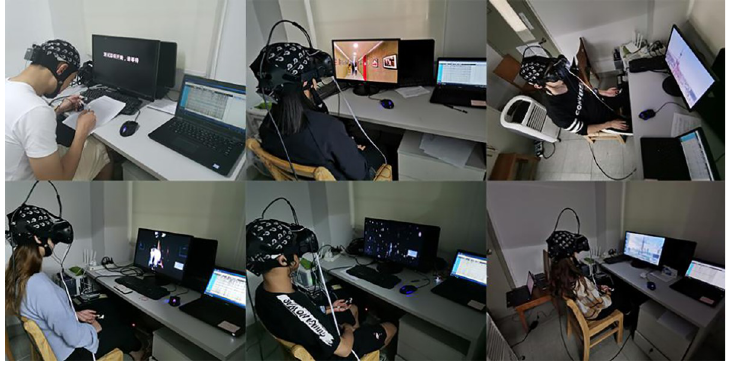
Fig 5. Experimental process and equipment connections.